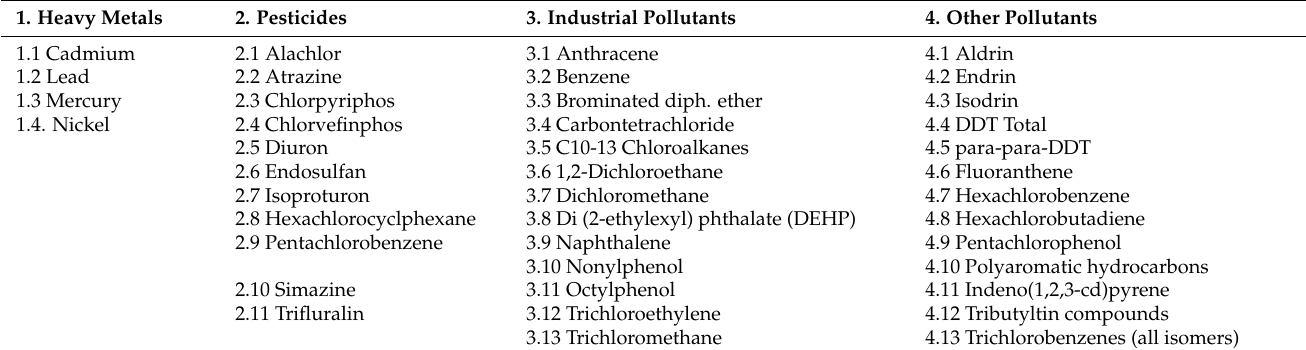
Table 1. Grouping of chemicals into pollutant